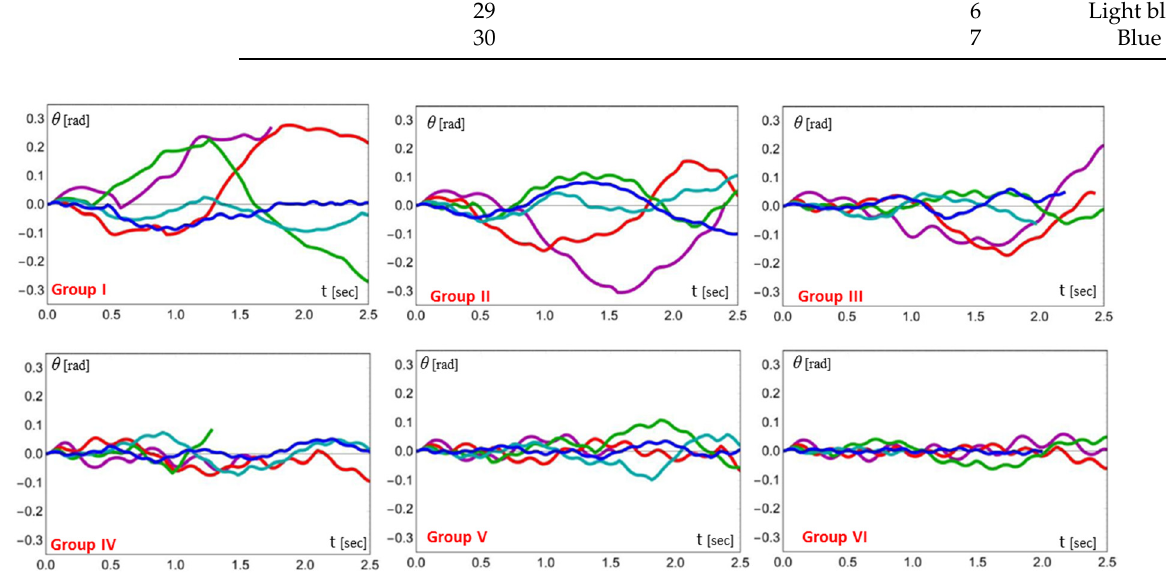
Figure 10. Rotation time histories ϑ (t) diagrams. Groups of conditions I–VI (Table 2).